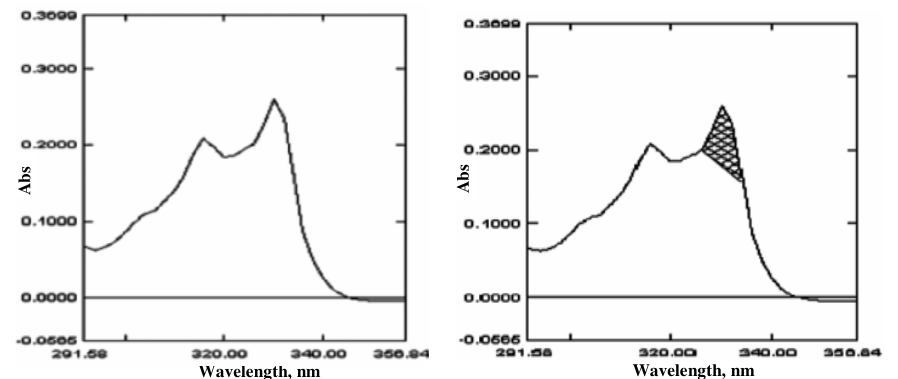
Figure 1. Zero order UV-spectrum of nabumetone (30 µ g/mL) showing absorptaion maxbma at 330 nm